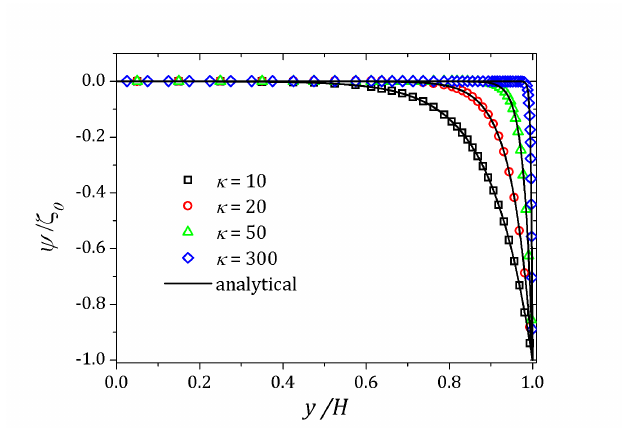
Figure 6. Potential ψ for different values of the Debye parameter. Results for κ = 10,20,50,300.